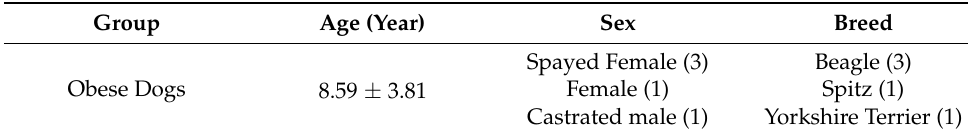
Table 1. Age, sex, and breed of the obese dogs in this study. Group